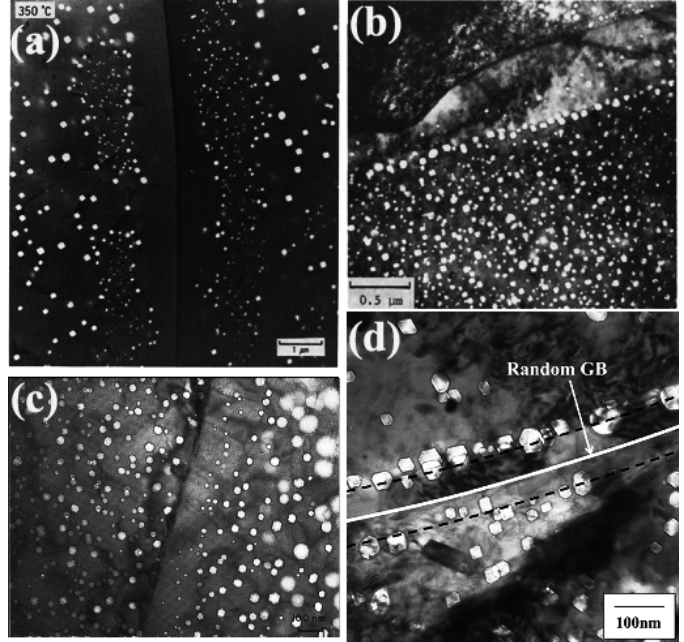
Figure 1. Morphology of void denuded zones (VDZs) along grain boundaries (GBs) in ( a ) copper irradiated at 330 °C [14]; ( b ) 304 stainless steel irradiated at 625 °C [17]; ( c ) nickel irradiated at high temperature [12]; and ( d ) PNC316CW stainless steel neutron-irradiated at 775 K to 103 dpa [16].